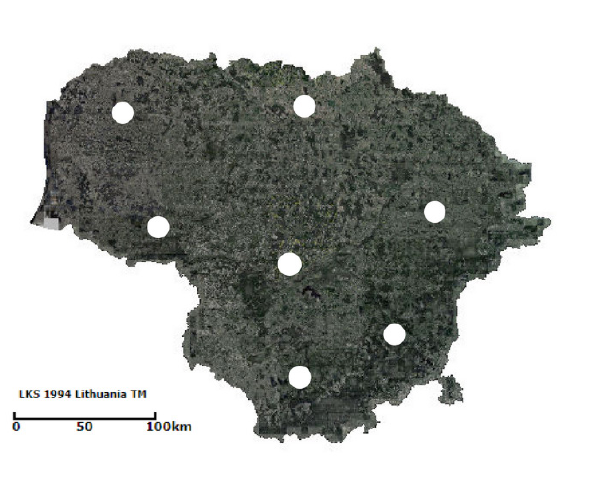
Figure 1. Locations of studied forests in